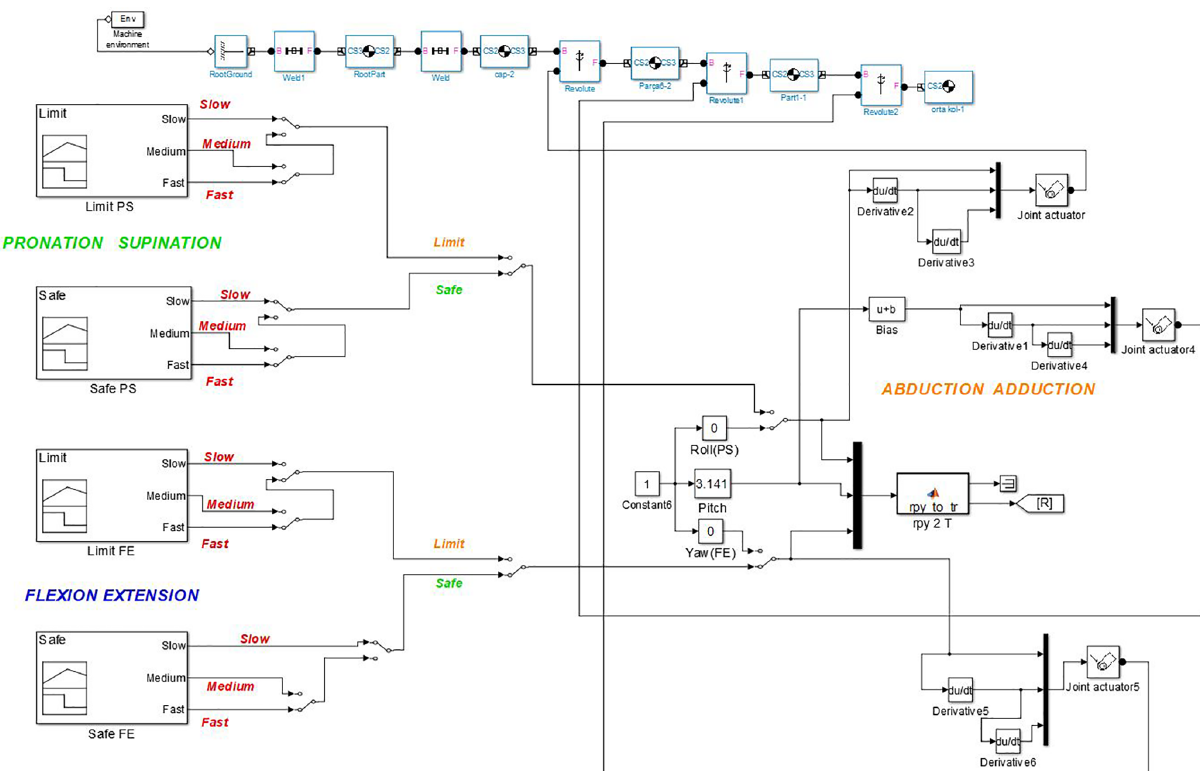
Figure 15. The model showing the trajectories and SimMechanics blocks of the exoskeleton.